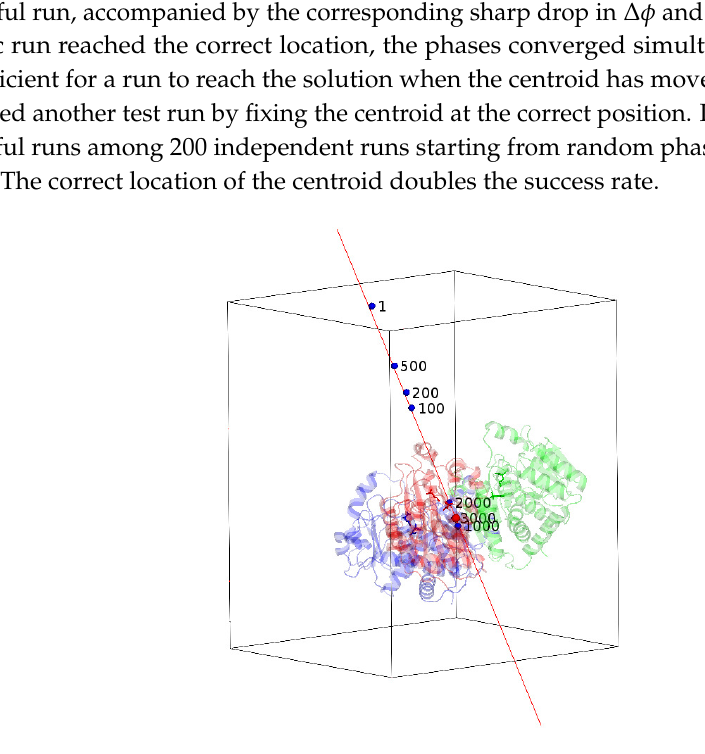
Figure 8. The blue spheres near the known NCS axis represent the locations of the calculated centroid of a successful run of 4NF2. The label shows the number of iterations. The initial position of the calculated centroid is random and far away from the correct position shown as the red sphere. At the 1000th iteration, it gets quite close to the correct position. At the 3000th iteration, it reaches the correct position and stays there after